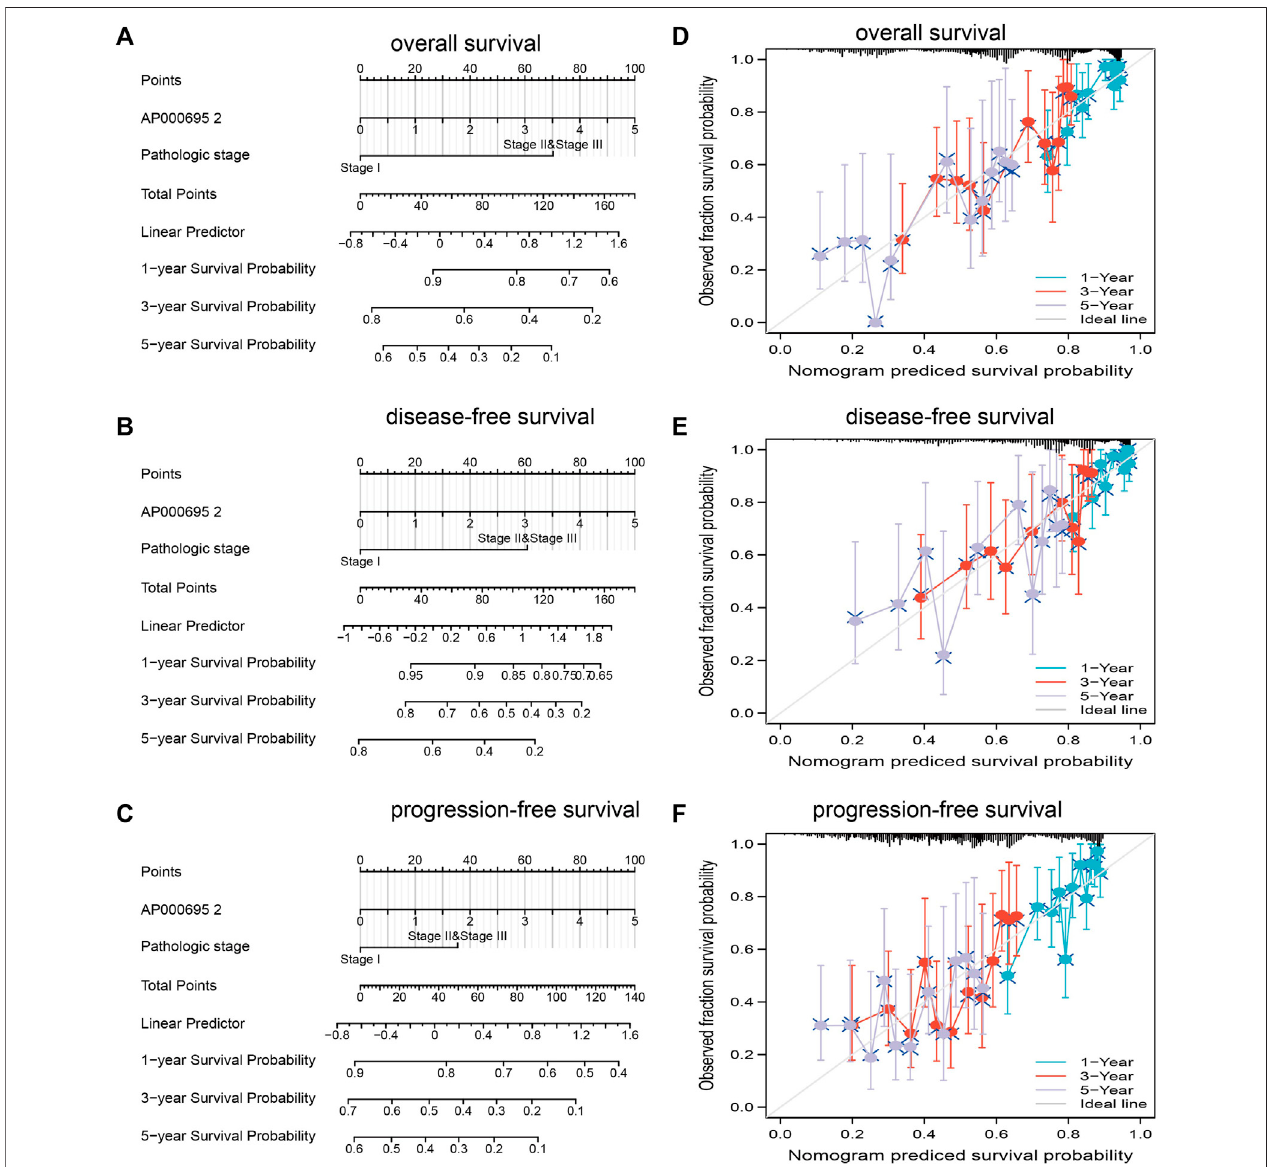
FIGURE 5 | Construction and performance validation of the lncRNA-AP000695.2-based nomogram for lung adenocarcinoma patients. (A – D) Nomogram to predict the overall survival, disease-free survival, and progression-free survival of lung cancer patients, and the calibration curve and Hosmer – Lemeshow test of nomograms in TCGA-lung adenocarcinoma cohort for overall survival, disease-speci fi c survival, and progression-free survival.